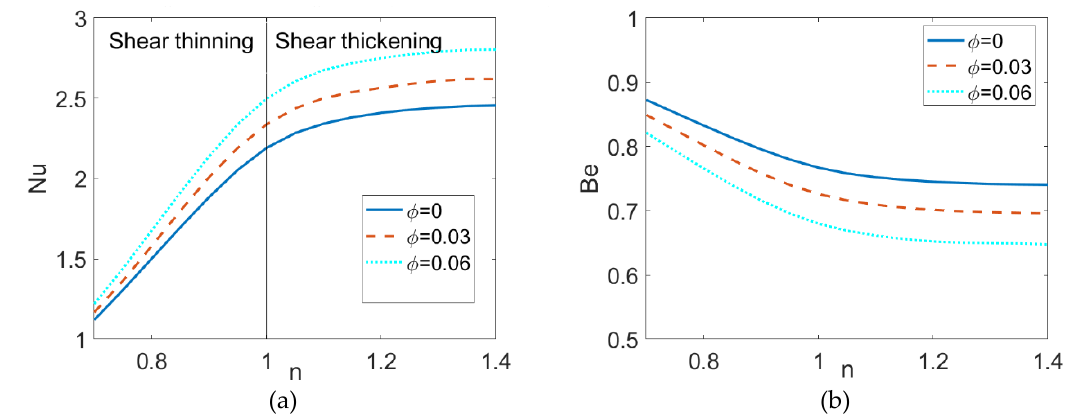
Figure 10. The variation of ( a ) Nusselt number and ( b ) Bejan number with flow behavior index for different nanoparticle volume fraction.